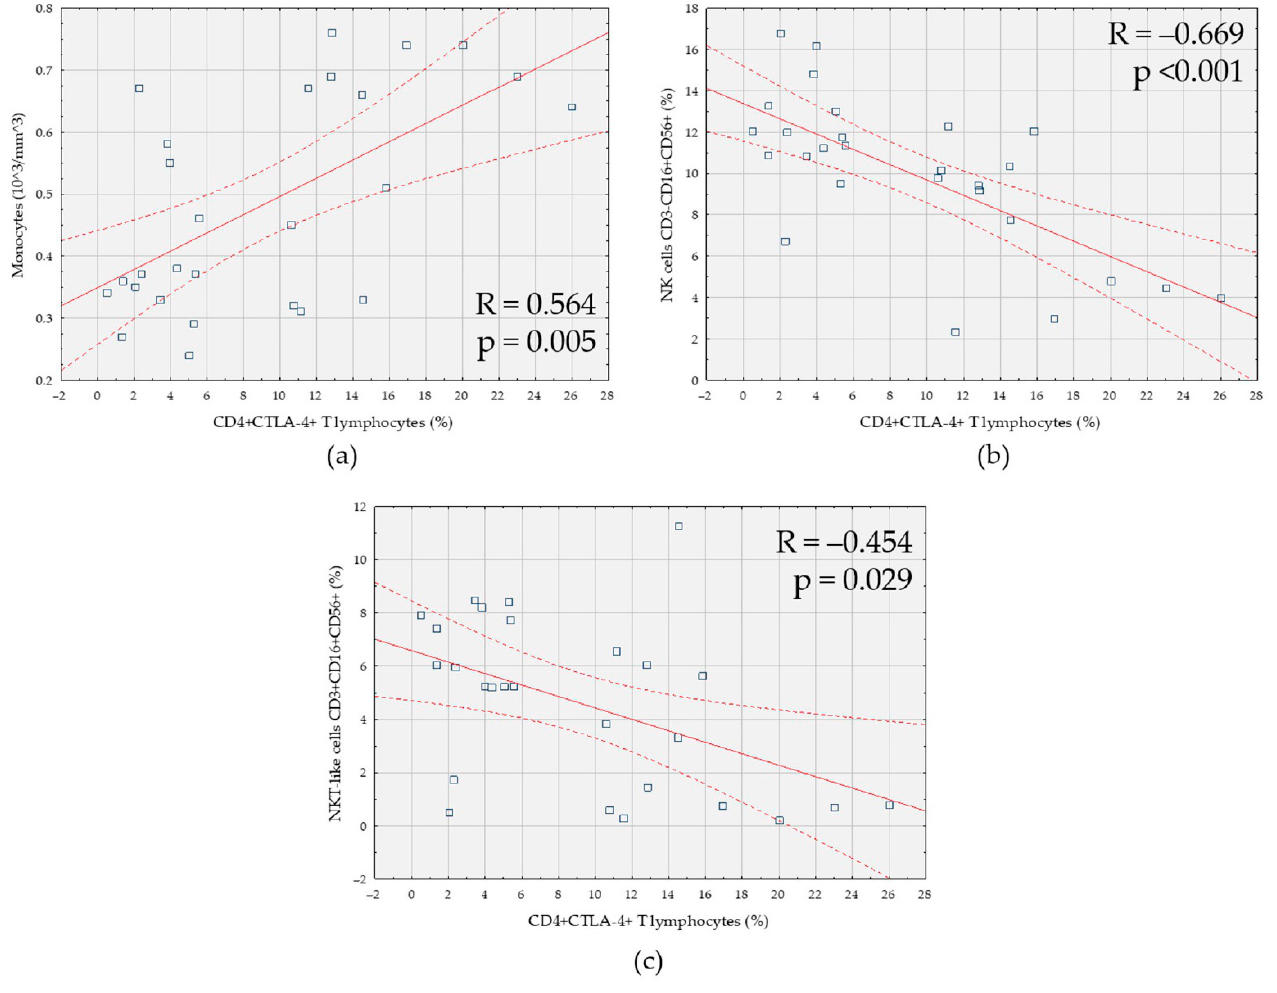
Figure 2. Correlation between the percentage of CD4+ T cells expressing CTLA-4 (CD4+CTLA-4+) and: ( a ) the number of monocytes; ( b ) the percentage of NK cells (CD3-CD16+CD56+); ( c ) the percentage of NKT-like cells (CD3+CD16+CD56+) in patients with endometriosis and coexisting infertility ( n = 27).